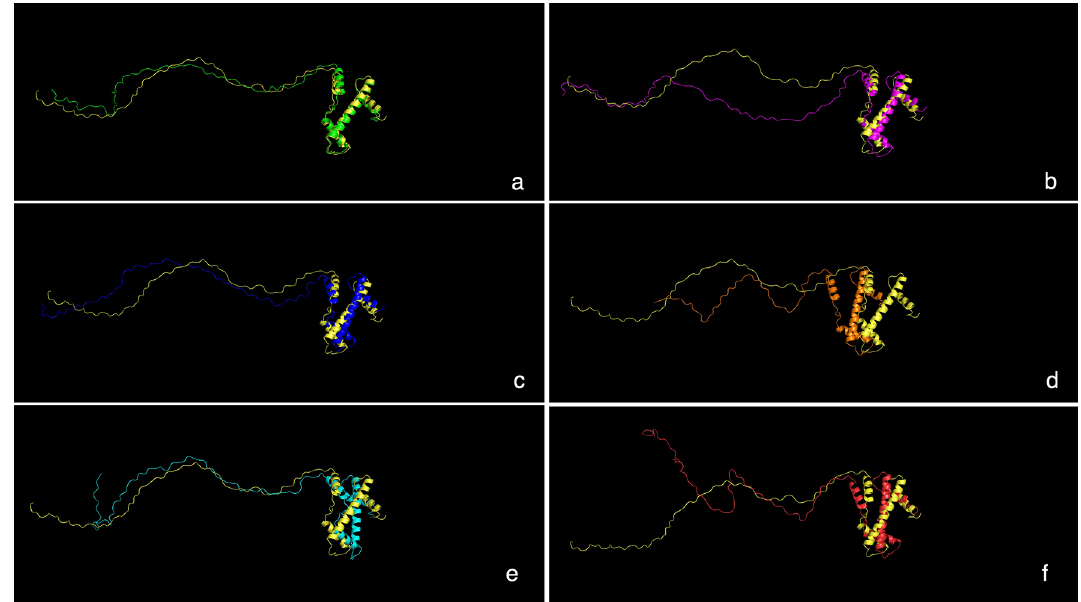
Figure 7. Comparison of 3D models of Oryza genus CENH3s: Superimposition of reference OsCENH3 (yellow) with ( a ) H5, ( b ) H10, ( c ) H12, ( d ) Hδ, ( e ) Hθ, and ( f ) Hζ. The models were generated using Modeller 10.1 and superimposed using PyMOL version